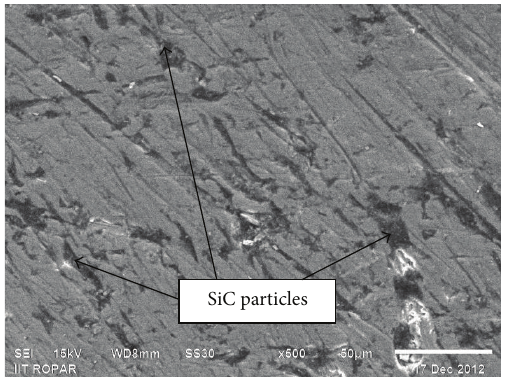
Figure 3: SEM micrograph of 6061 Al / SiC